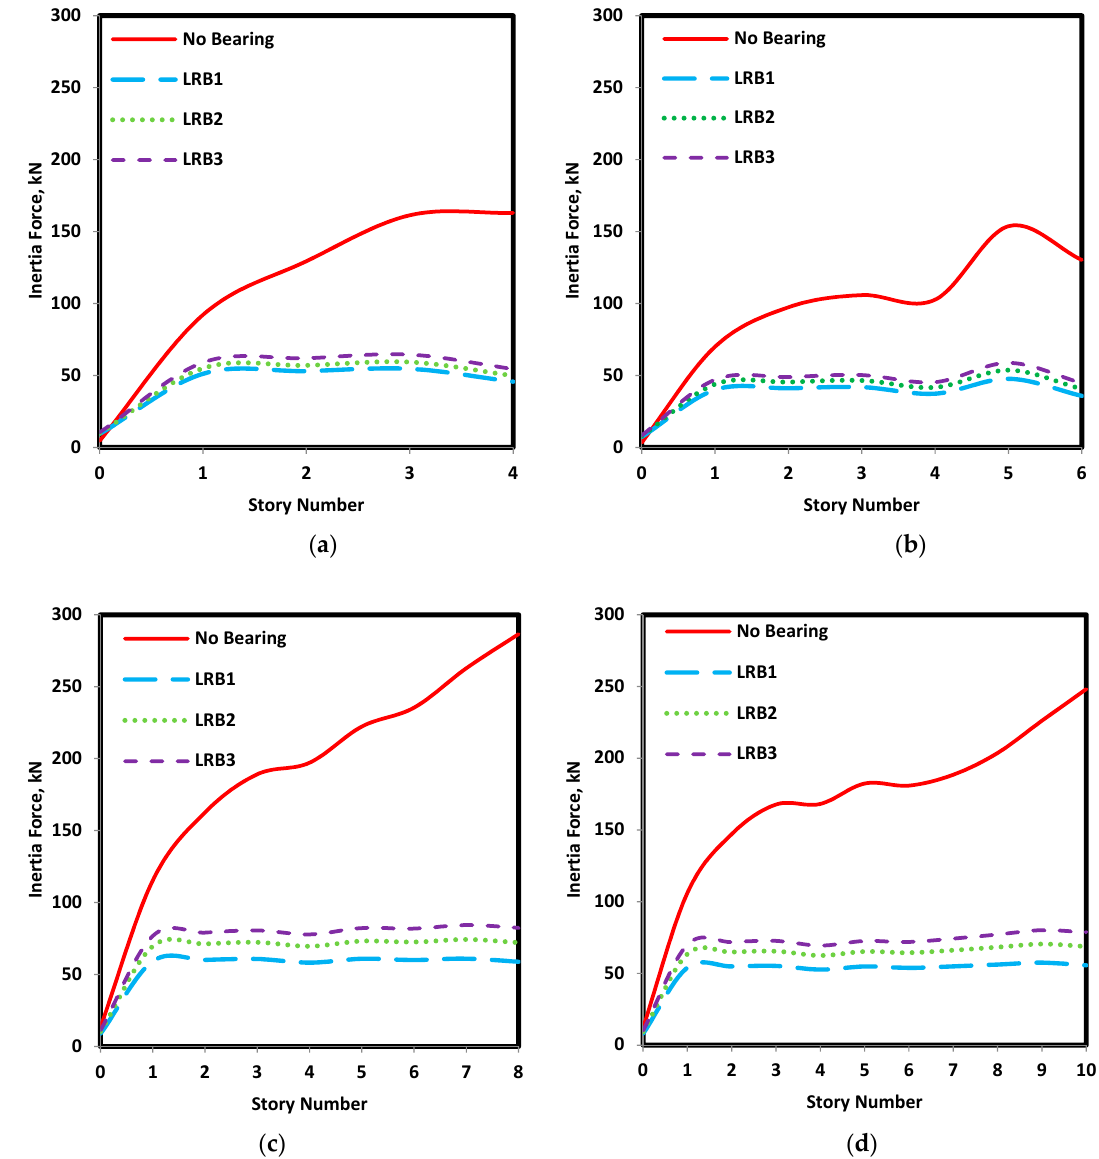
Figure 9. Story inertia forces at: ( a ) 4-story building, Ti = 1.5 s; ( b ) 6-story building, Ti = 2.0 s; ( c ) 8-story building, Ti = 2.5 s; and ( d ) 10-story building, Ti = 3.0 s.